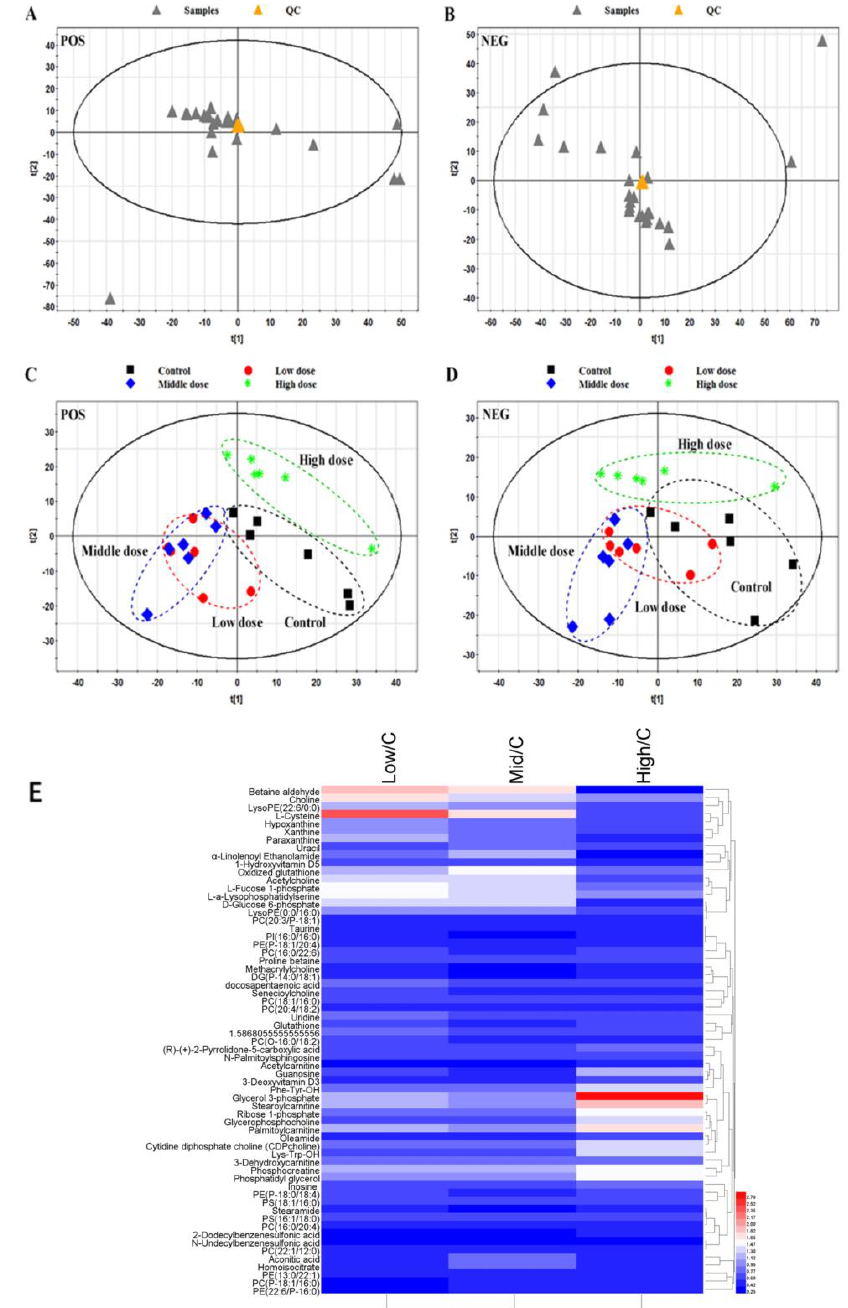
Figure 5. Score plots of the multivariate statistical analysis for the control group and 2,2′,4,4′-tetrabromodiphenyl ether (BDE-47)-treated groups (n = 6). Principal component analysis (PCA) score plot of the normal and quality control samples in ( A ) positive mode and ( B ) negative mode. Partial least squares discriminant analysis score plot for the control group and BDE-47-treated groups in ( C ) positive mode and ( D ) negative mode. ( E ) Hierarchical clustering of identified metabolites among the three groups (n = 6).